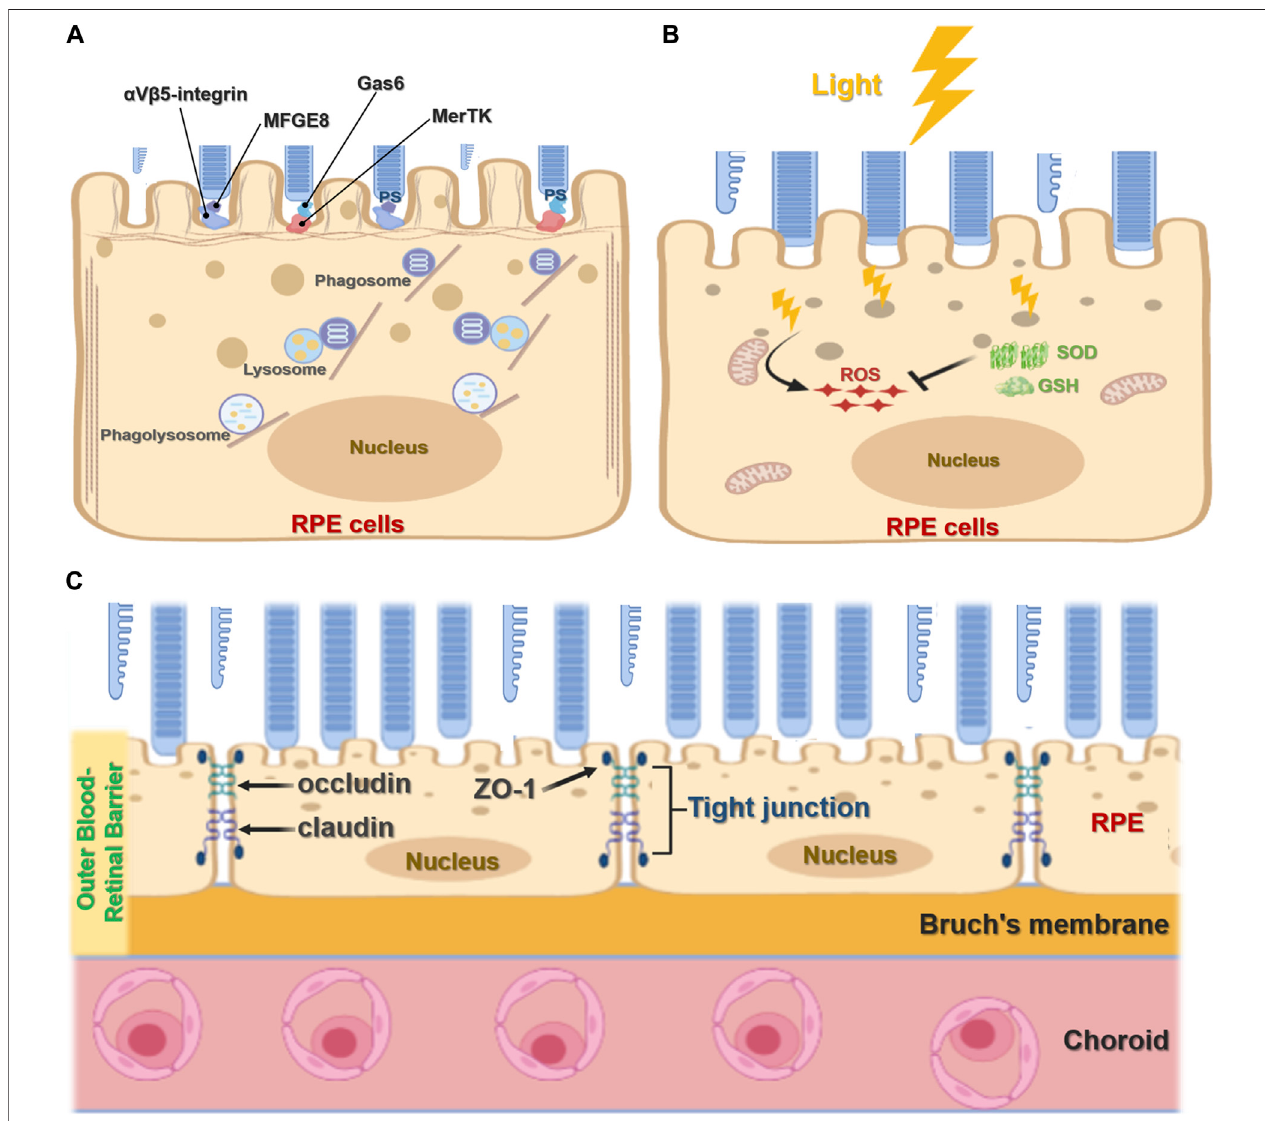
FIGURE 2 | Function of retinal pigment epithelial cells. (A) , The phagocytic function of RPE cells. RPE cells recognize and bind phosphatidylserine (PS) exposedbyPOSthroughMerTK/Gas6 and α V β 5-integrin/MFGE8pathways toinitiatephagocytosis. Itfurtherformsphagosomes and bindswithlysosomestoformthe phagolysosome, which digests POS. (B) , Antioxidant function of RPE cells. Light stress produces ROS. RPE cells absorb light through melanin or eliminate ROS accumulationthroughantioxidantssuchassuperoxidedismutase(SOD)andglutathione(GSH). (C) ,RPEcellbarrierfunction.TheRPEformsanouterblood-retinal barrier between the interior of the retina and the choroid. The RPE cells form tight junctions, including ZO-1, occludin, and claudin, which act as barriers.